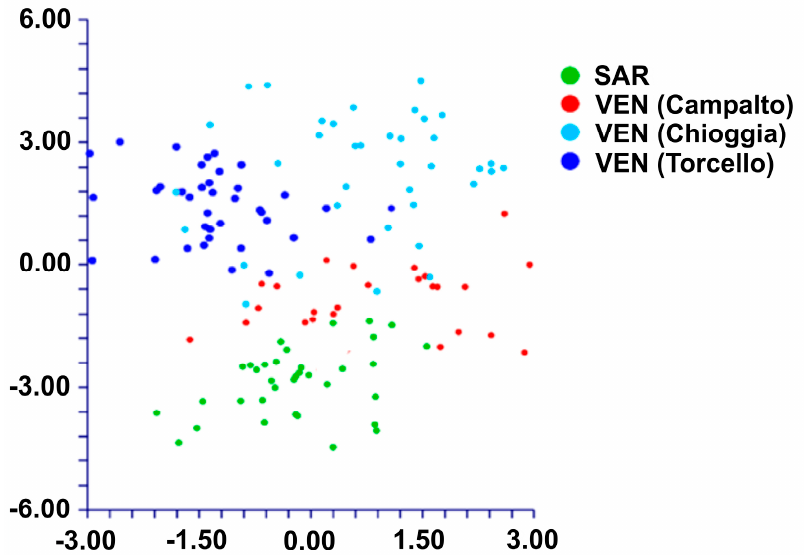
Figure 11. DA (first (axis y) vs. second (axis x) components) performed of groups classified using the